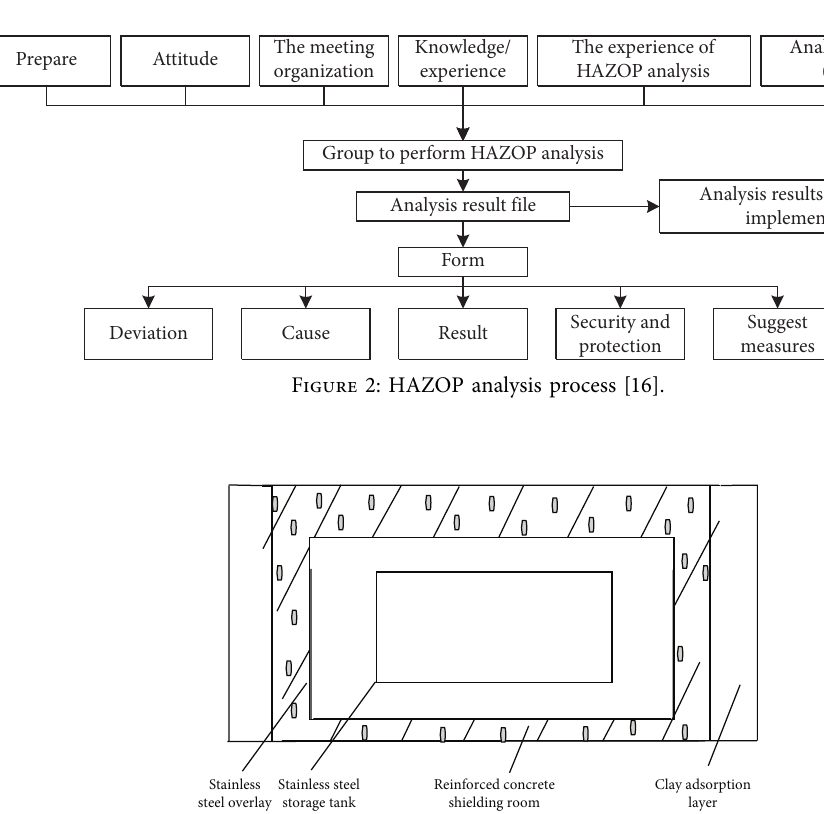
Figure 1: The analysis flow chart of